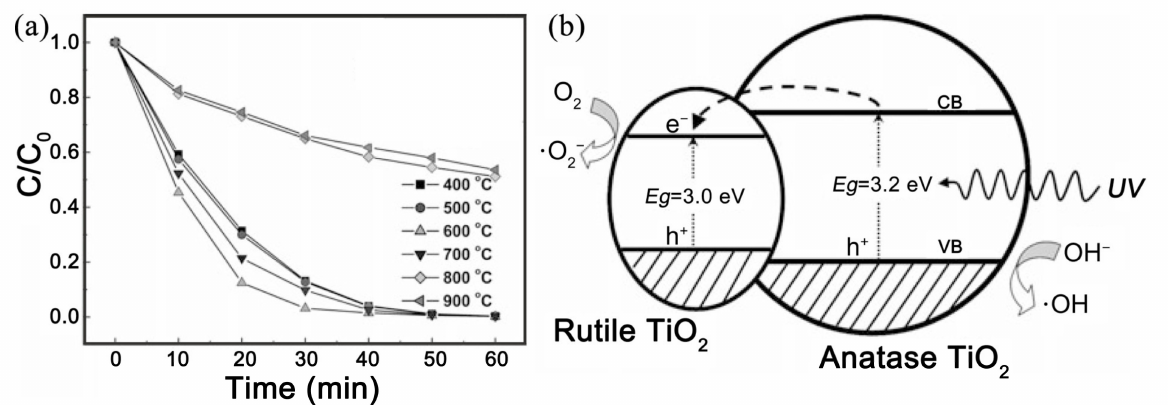
Figure 11. Photocatalytic performance ( a ) and proposed mechanism ( b ) of anatase–rutile heterostructured TiO 2 ceramic nanofibers for dye degradation under UV light. (Redrawn with the permission of Ref. [60]. Copyright 2021 John Wiley and Sons).